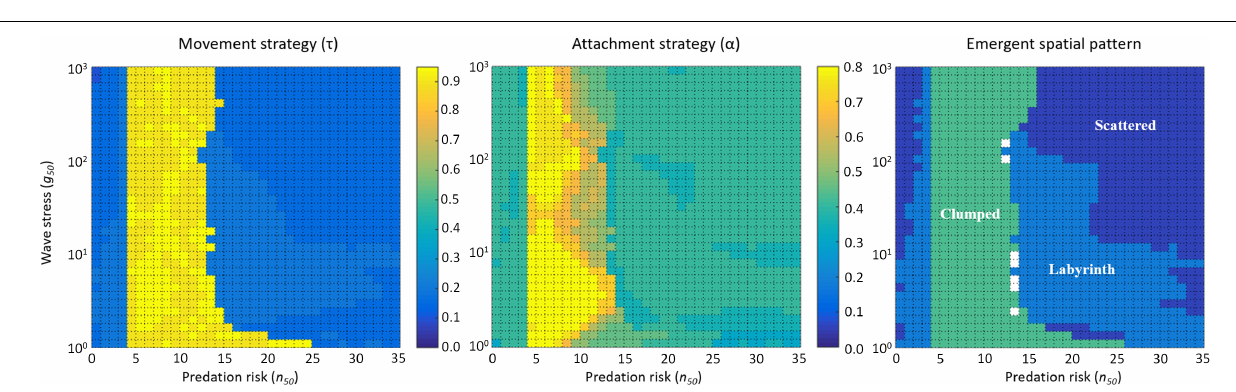
Frontiers in Ecology and Evolution | www.frontiersin.org